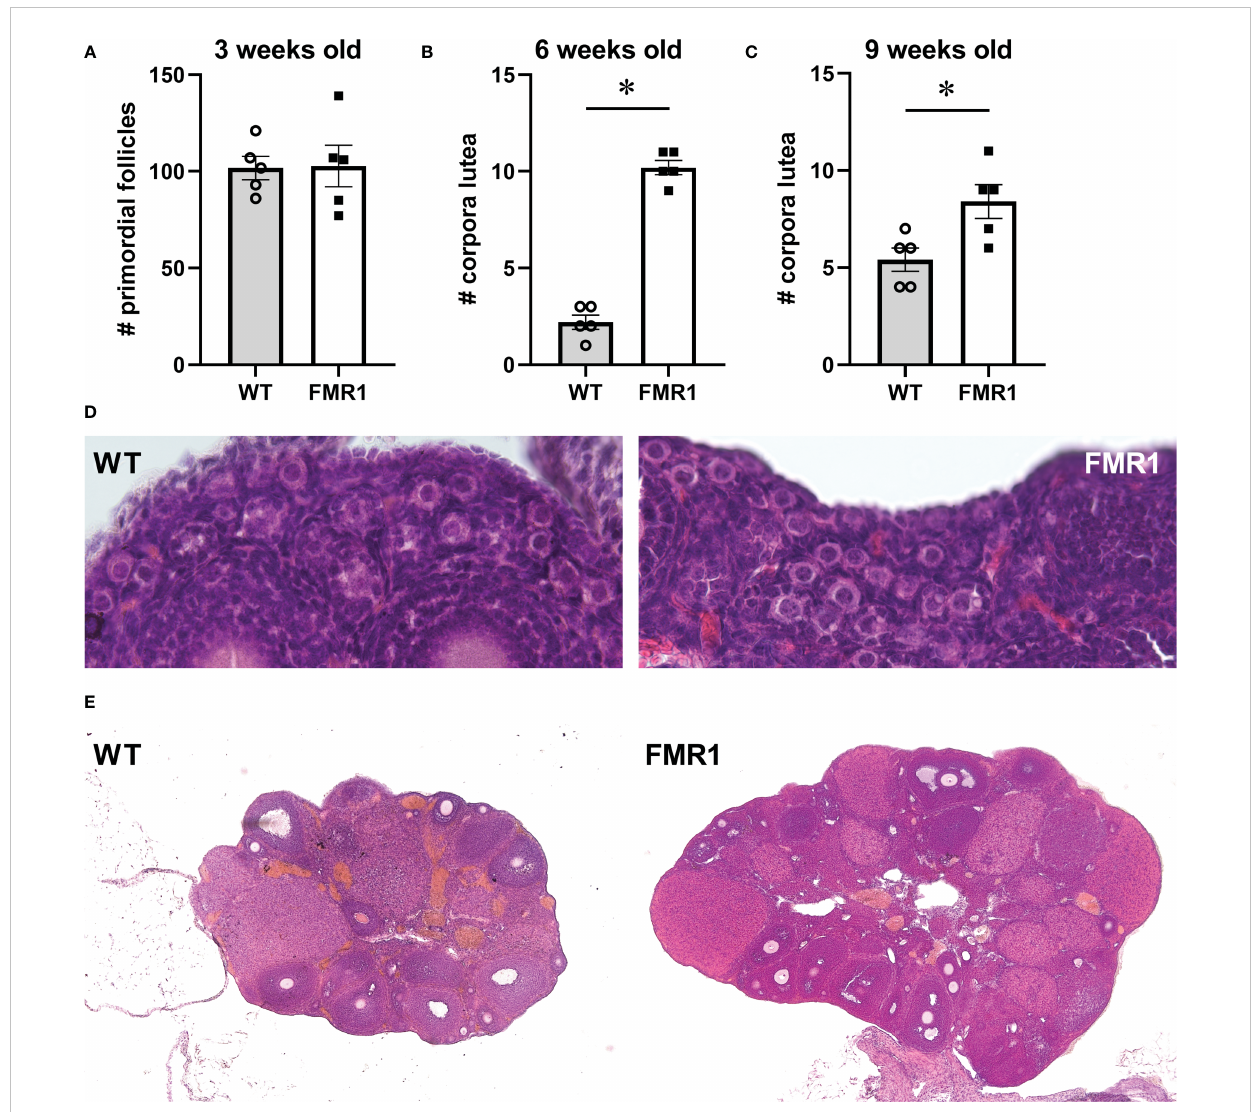
FIGURE 2 Ovarian histology demonstrates more corpora lutea in young Fmr1 KO mice. Fmr1 KO females (FMR1, white bars represent group mean +/- standard error while each black square represents one animal) were compared to wild type controls (WT, gray bars represent mean +/- standard error, each open circle represents one animal). (A) Primordial follicles were counted at 3 weeks of age. Each point represents one mouse, and an average of 4 separate 1x10 -8 m 2 areas in the ovary cortex of each mouse. (B, C) corpora lutea were counted at 6 (B) and 9 weeks of age (C) throughout each ovary. (D) representative images of ovaries from 3-week old mice to observe primordial follicles (630x). (E) representative images of ovaries at 6 weeks of age to observe numbers of corpora lutea (40x). Statistical signi fi cance, indicated with * (p < 0.05) was determined with t-test followed by Tukey ’ s post hoc